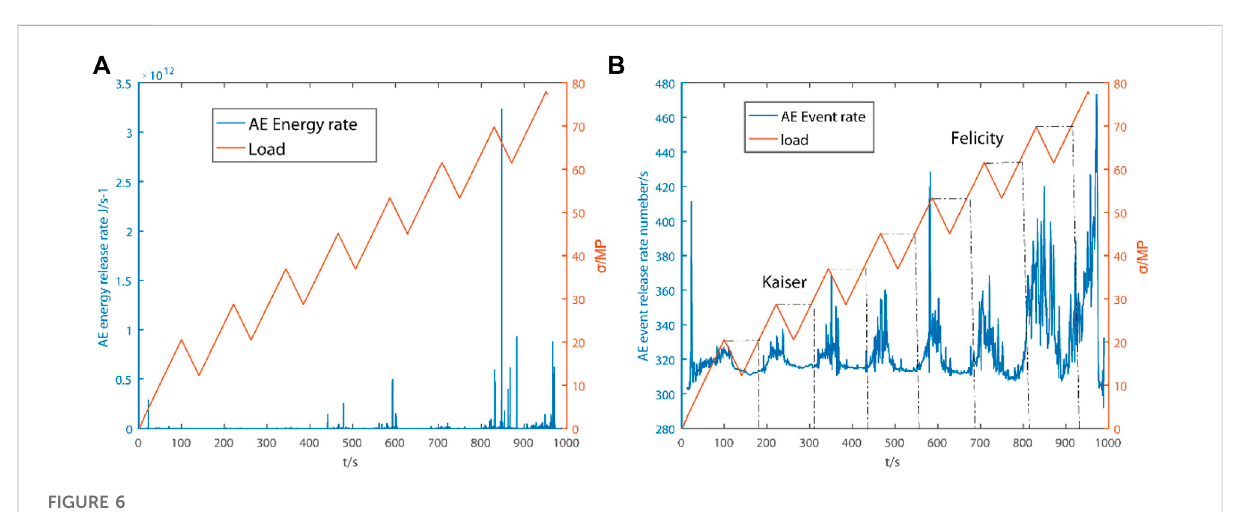
FIGURE 6 AE energy release rate (A) and event release rate (B)